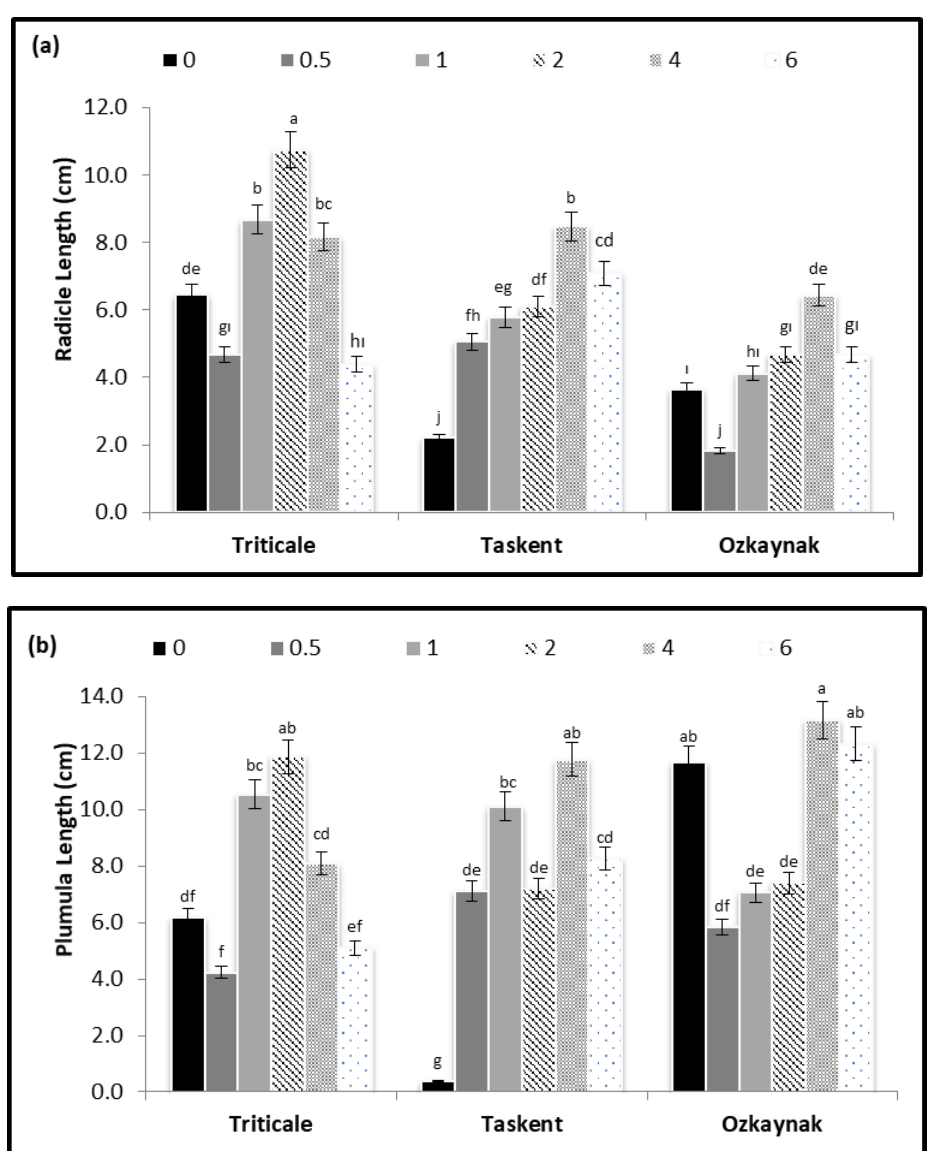
Figure 2. Effect of biochar rate on ( a ) radicle length, and ( b ) plumula length of Triticale, Taşkent and Özkaynak. Different letters above the bars suggested that these values are significantly different at p ≤ 0.05.